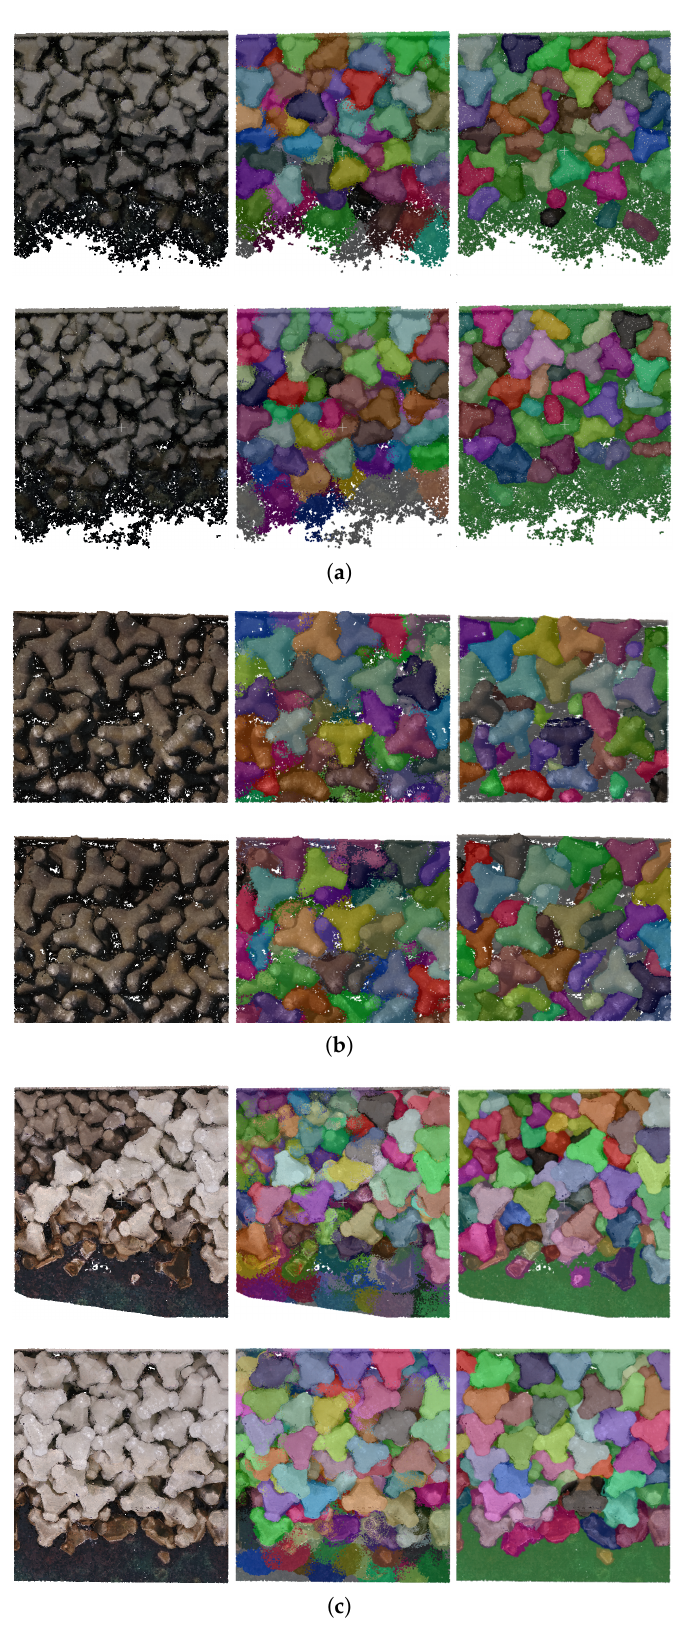
Figure A2. Additional instance segmentation results on Sawara port ( a ), Todohokke port ( b ) and Era port ( c ). The left column is the point cloud scene measured by UAV. The middle column is the predicted results of instance segmentation, and the last column is the ground truth. Different colors represent different